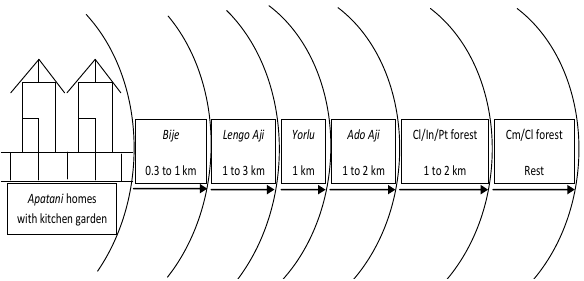
Fig. 3. Land use pattern in Ziro Valley. Cl-Clan, In-Individual, Pt- Private,